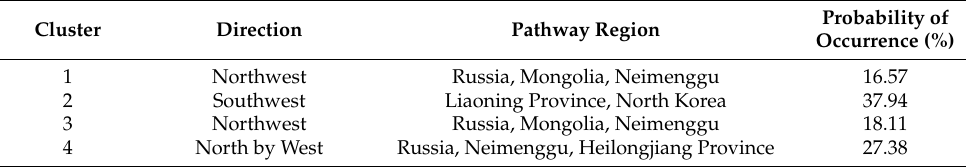
Figure 9. Cluster distribution of backward trajectory in 2019. The trajectories are divided into four clusters: cluster 1 is in red; cluster 2 is in green; cluster 3 is in blue; cluster 4 is in black. Table 3. Backward trajectory clustering results.